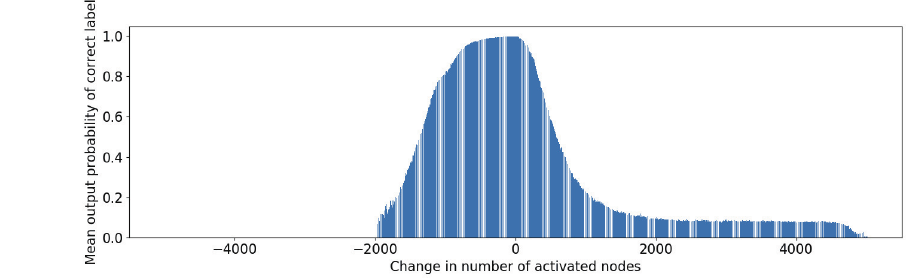
Figure 21: Simulation of relationship between the change in the number of all layers’ activated nodes and the mean output probability of the correct label in the CNN model.